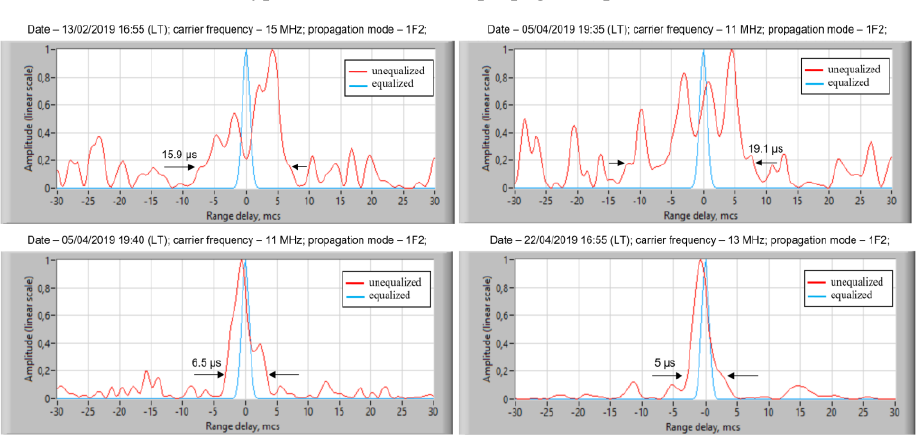
Fig. 2. Unequalized and equalized IR of 1-MHz